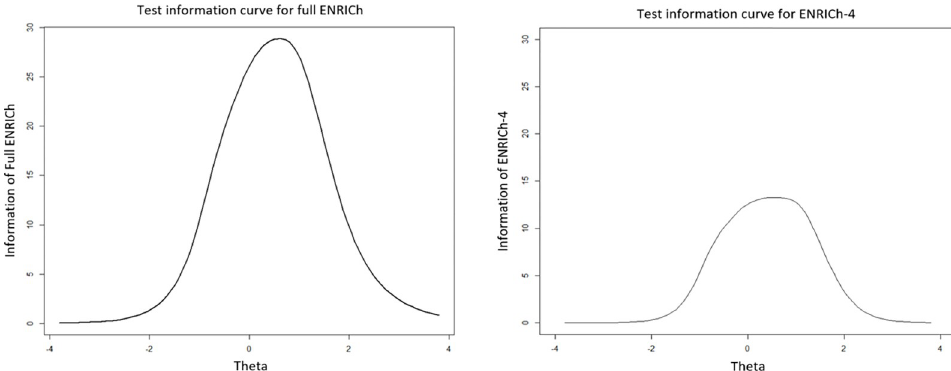
Fig 7. Test information curves for full ENRICh with 15 items and ENRICh with 4